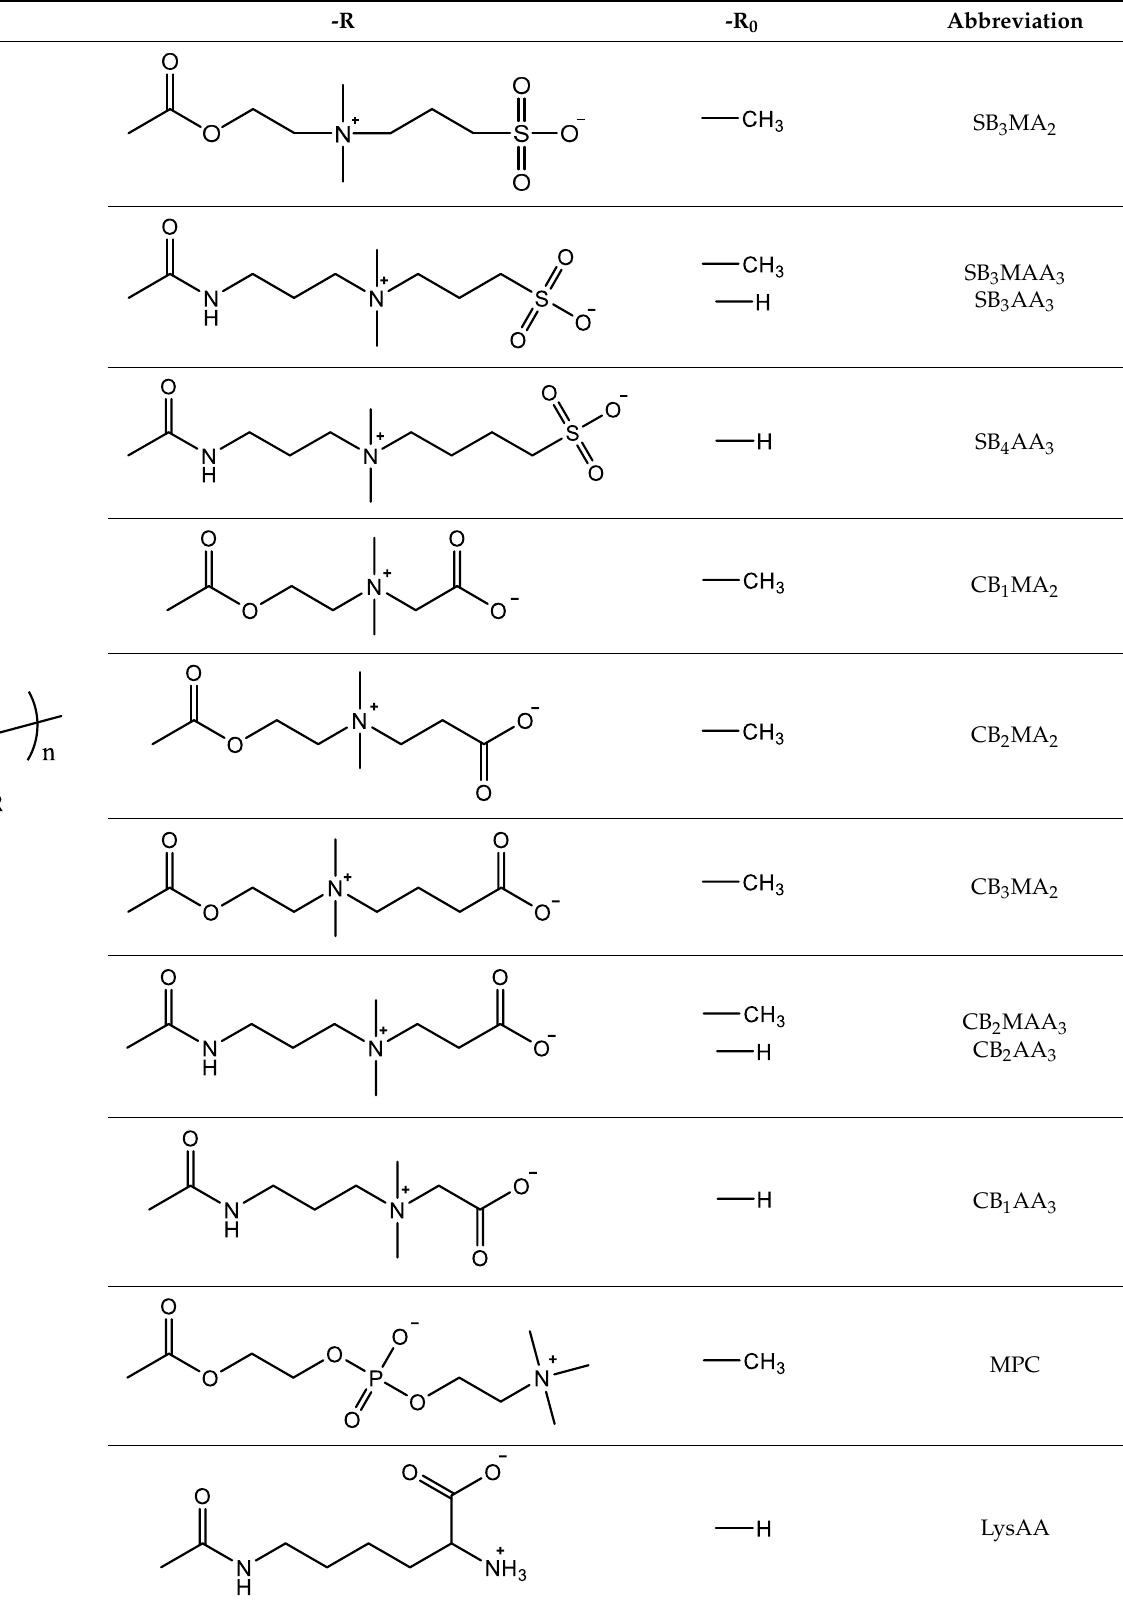
Table 1. Zwitterionic polymers are commonly used as mechanical energy dissipation units through dipole interaction.